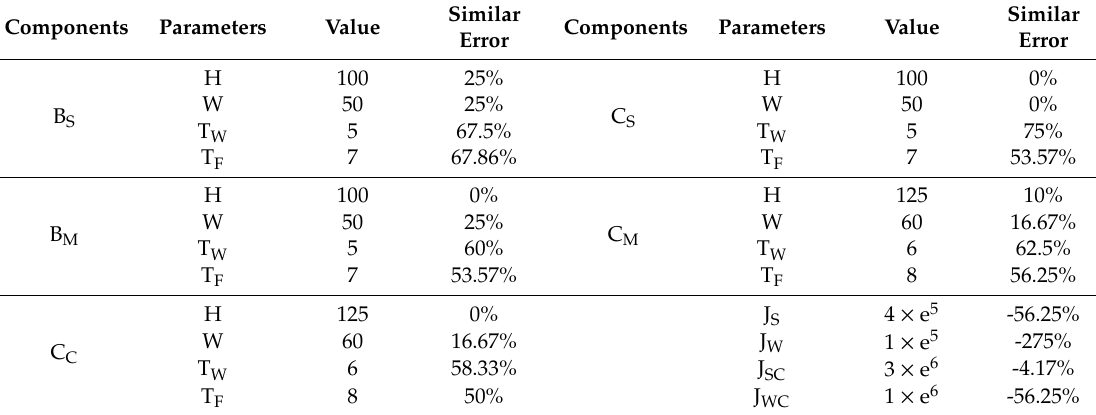
Table 7. Similar error of each